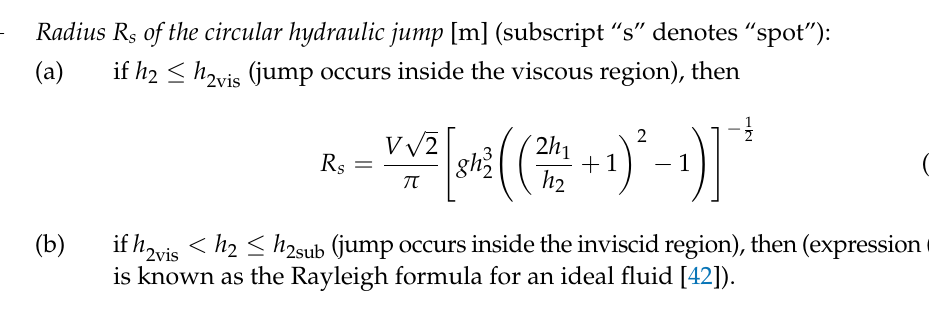
Figure 4. Schematic of the flow of a circular liquid jet on a horizontal plate with the formation of a circular hydraulic jump. The zones of jet impingement, and supercritical and subcritical flow are shown. Supercritical flow zone is conventionally divided into two regions: inviscid and viscous.